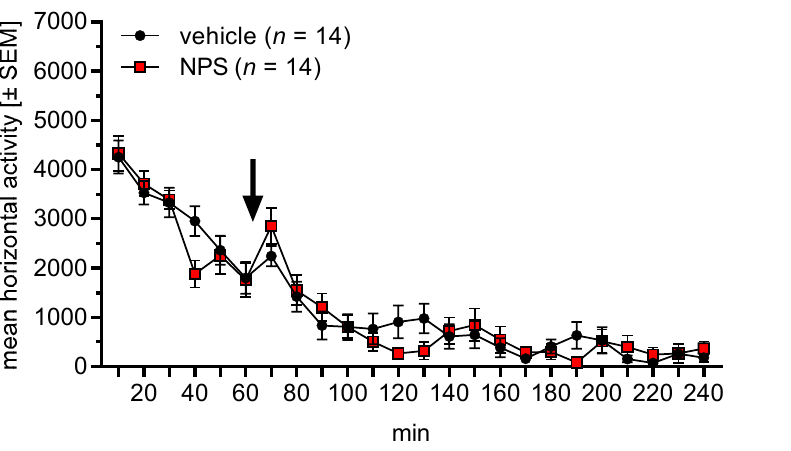
Figure 3. Effects of nasal NPS administration on locomotor activity (arbitrary units) in the open field. The arrow indicates the administration time point. Nasally applied NPS did not affect locomotor activity.